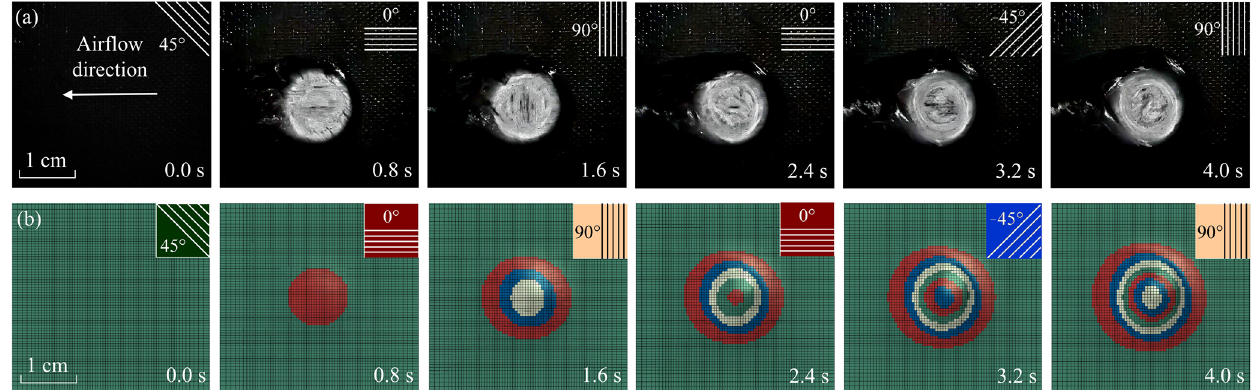
Figure 9. The ablative morphology at different times. ( a ) Experimental results; ( b ) numerical results.